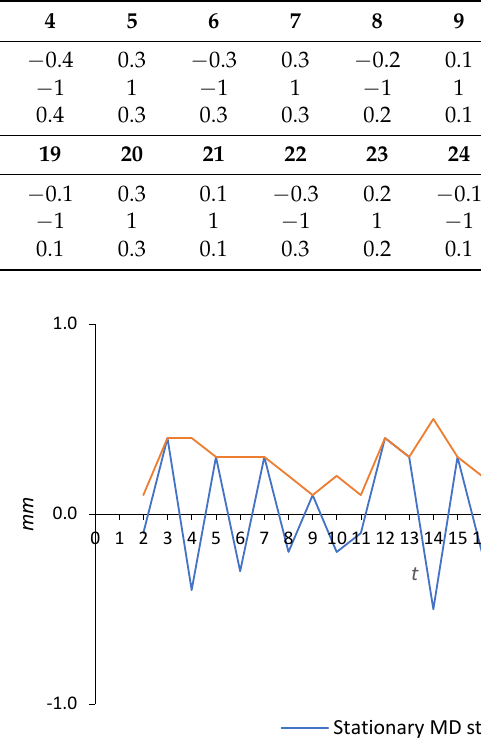
Table 10. Transformation from MD stationary to NN state of series.